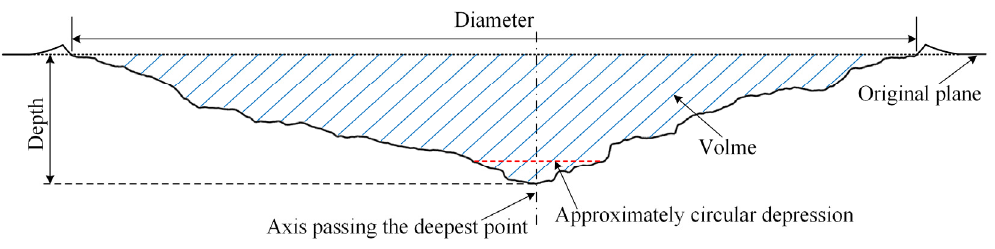
Figure 8. Schematic of the section of the impact crater (Shot No. 10).